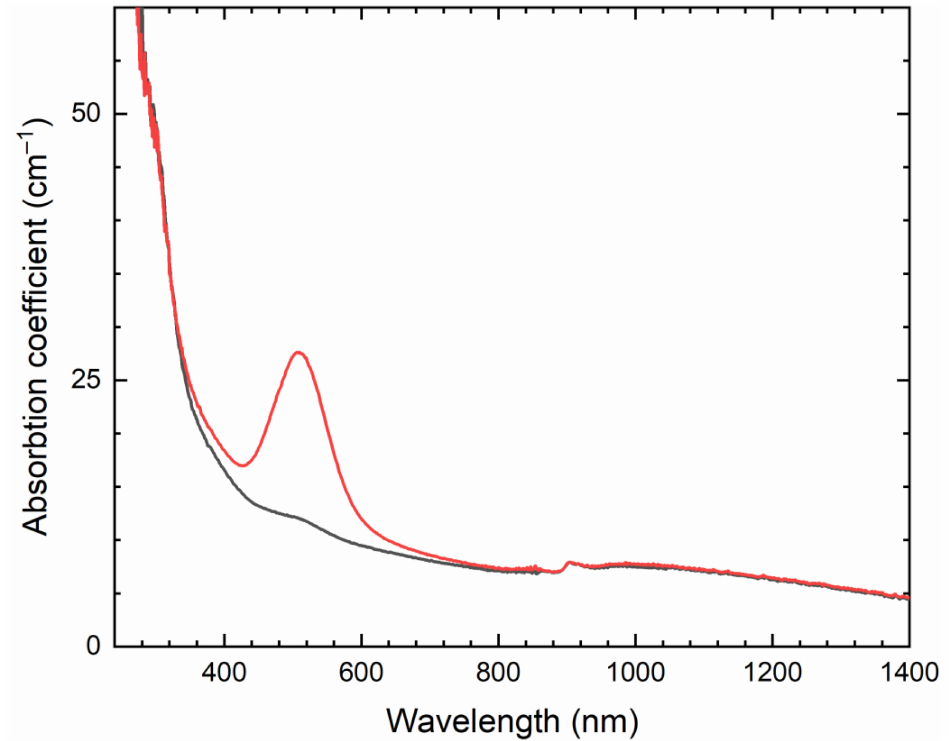
Figure 16. Absorption spectrum of tugtupite (Sample 8): almost colorless (black curve) and purple after irradiation with UV light (red